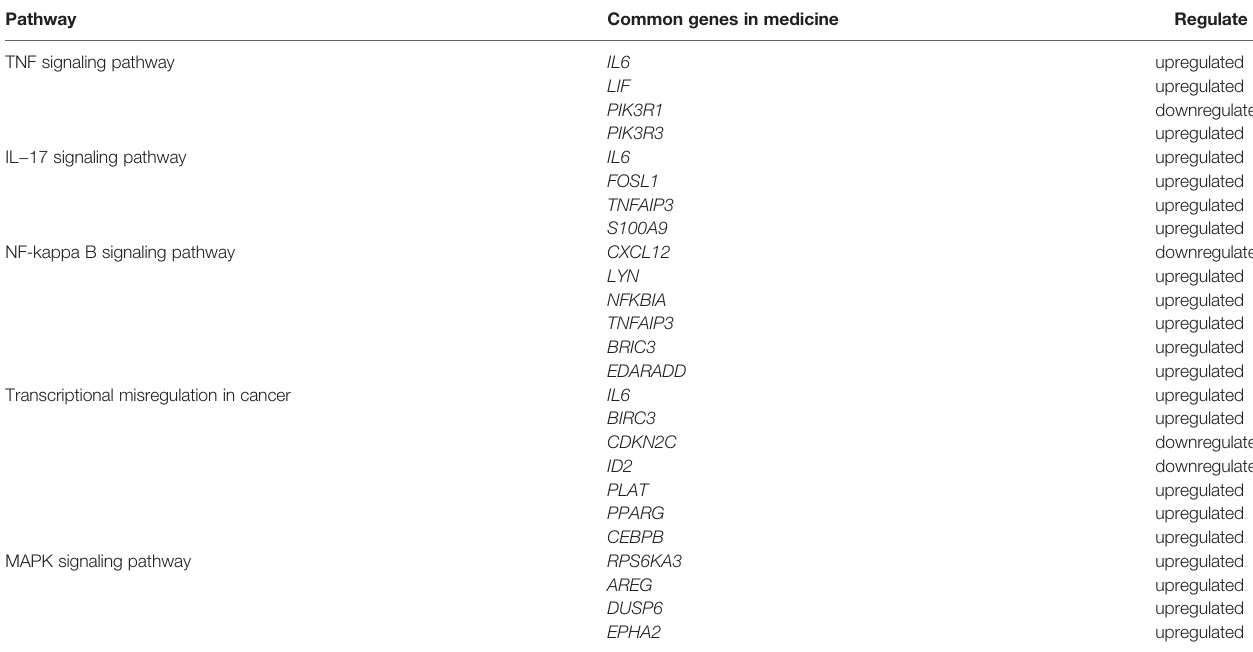
TABLE 3 | The summary of the common genes of the fi ve pathways in cancer cells treated with three TCM candidates.